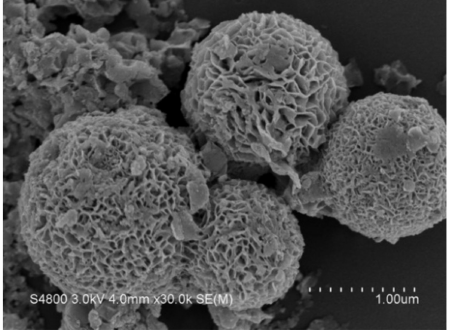
Figure 2. SEM image of the as-prepared SnIn 4 S 8